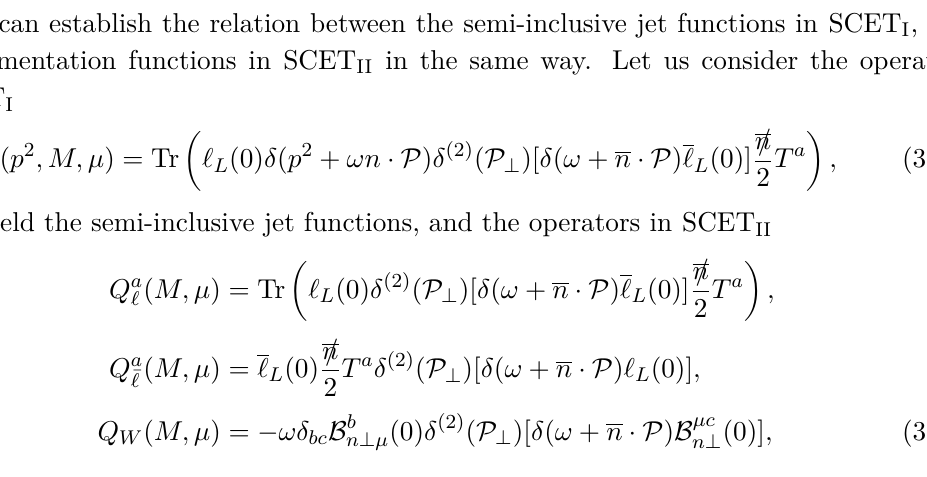
∼ Q T are integrated out to obtain SCET II from SCET I hc